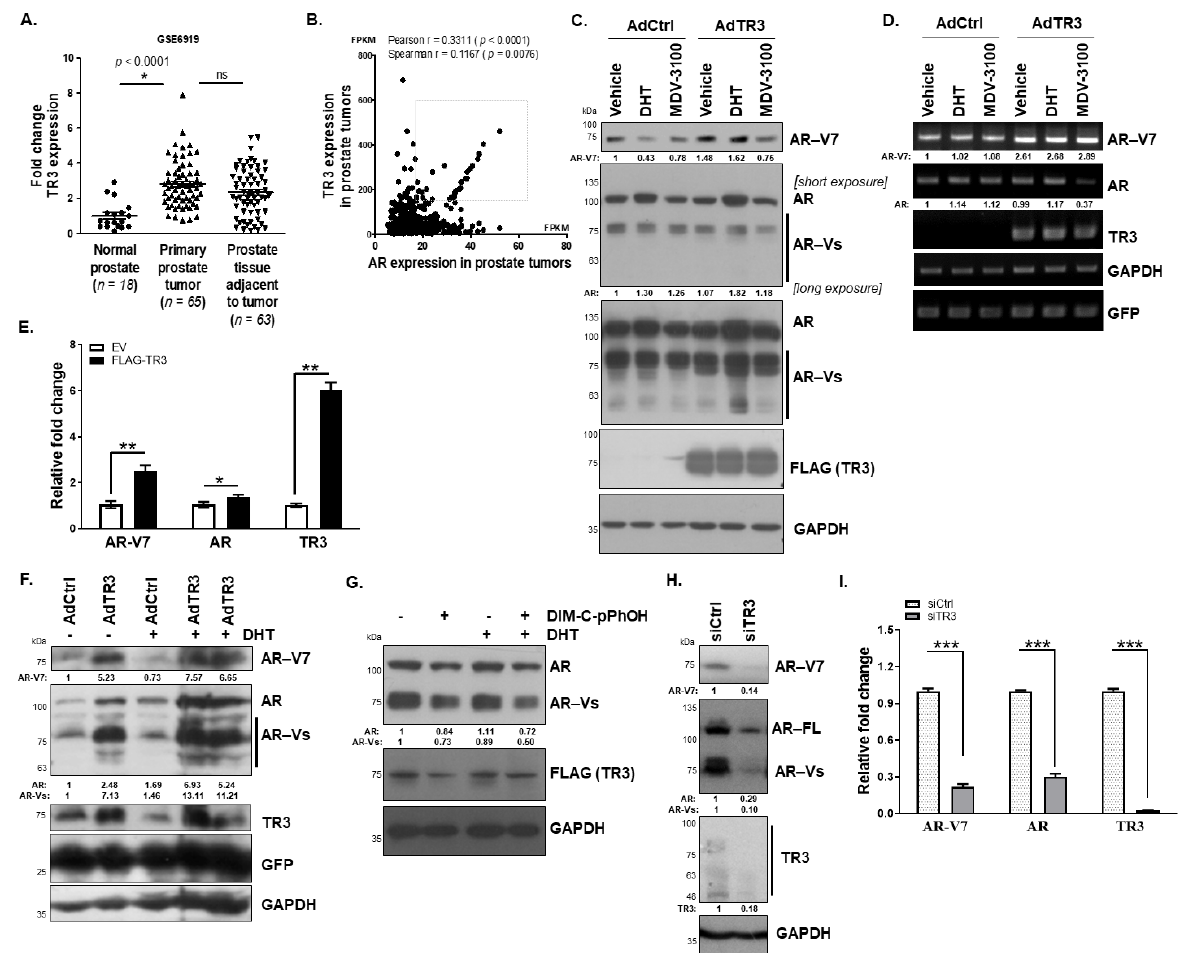
Figure 1. TR3 regulates the expression of AR and AR-Vs in prostate cancer. ( A ) Elevation of TR3 in prostate tumors. The graph shows TR3 mRNA levels in normal human prostate ( n = 18), primary prostate tumor ( n = 65), and prostate tissue adjacent to tumor ( n = 63). The data were extracted from the public microarray data established by the Pathology Department of Houston Methodist University Hospital. The fold change of TR3 expression in tissues was obtained by normalizing TR3 level in each tissue to the mean of those in normal prostate tissues. Data are shown as mean ± SEM. *, p < 0.001; ns, not significant; one-way ANOVA analysis with Tukey’s post-hoc test. ( B ) Positive correlation between TR3 and AR expression levels in prostate tumors. The x and y axes denote Fragments Per Kilobase of exon per Million reads (FPKM), which were extracted from The Cancer genome Atlas (TCGA) Prostate Tumors’ Pathology Database ( n = 494). Pearson r or Spearman r and p values were analyzed using correlation analysis with two-tailed Pearson or two-tailed Spearman test, respectively. ( C – F ) TR3 overexpression increases the expression levels of AR and AR-Vs. Representative western blot ( C ) and RT-PCR ( D ) analysis showing the protein levels of AR and AR-Vs, and the appearance of other AR-Vs in AdTR3- or AdCtrl-infected CWR22Rv1 cells, which were treated with 10 nM